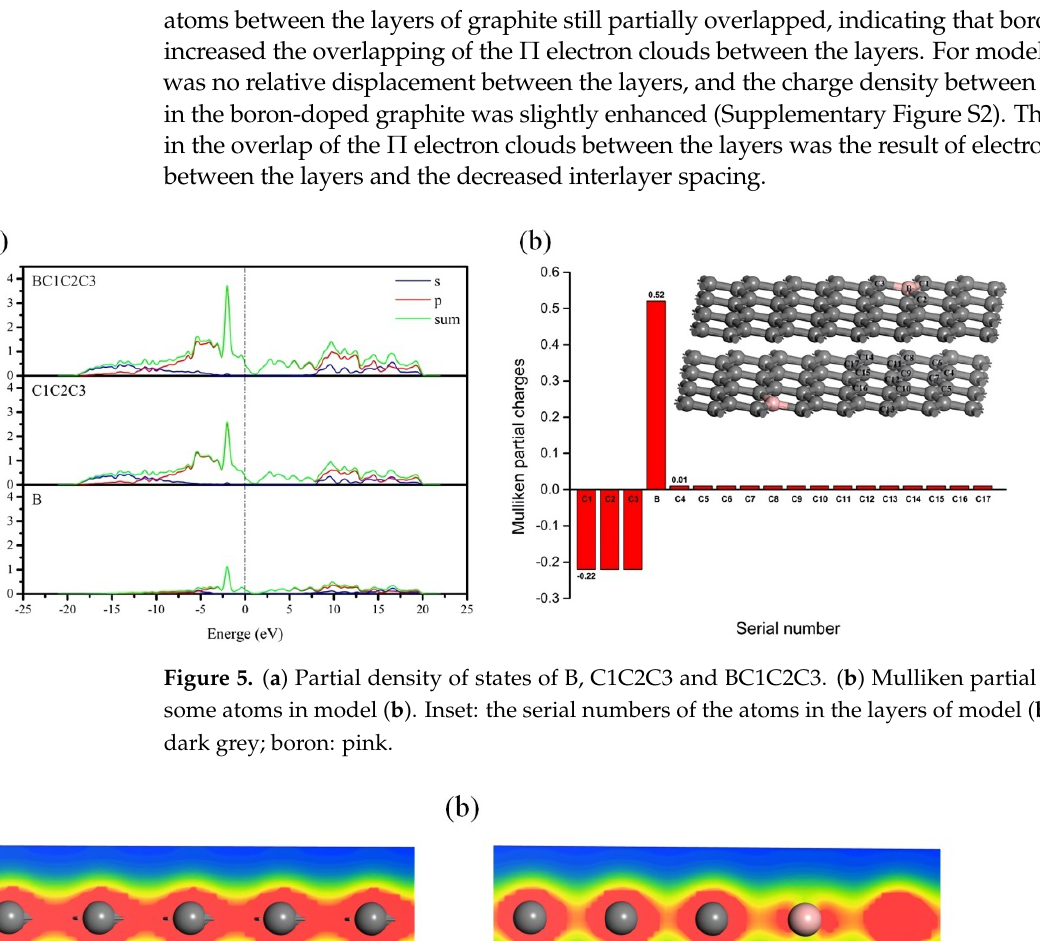
Figure 5. ( a ) Partial density of states of B, C1C2C3 and BC1C2C3. ( b ) Mulliken partial charges of some atoms in model ( b ). Inset: the serial numbers of the atoms in the layers of model ( b ). Carbon: dark grey; boron: pink.